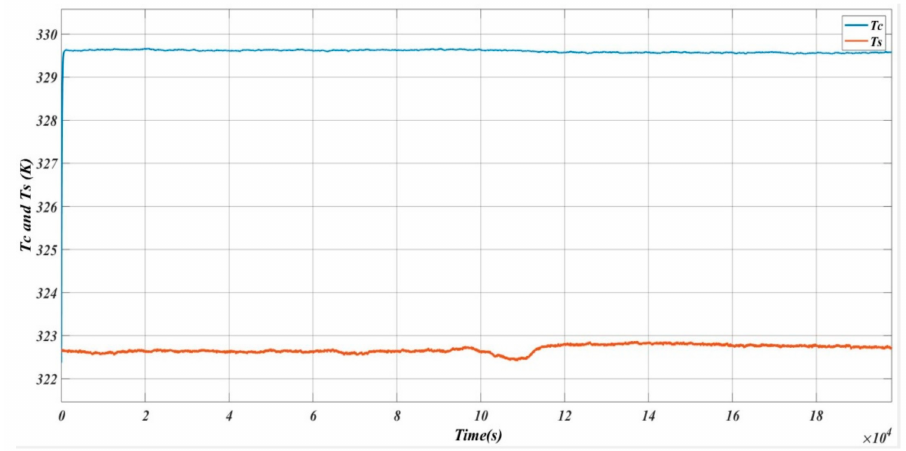
Figure 12. The plot of the estimated T c and measured T s .